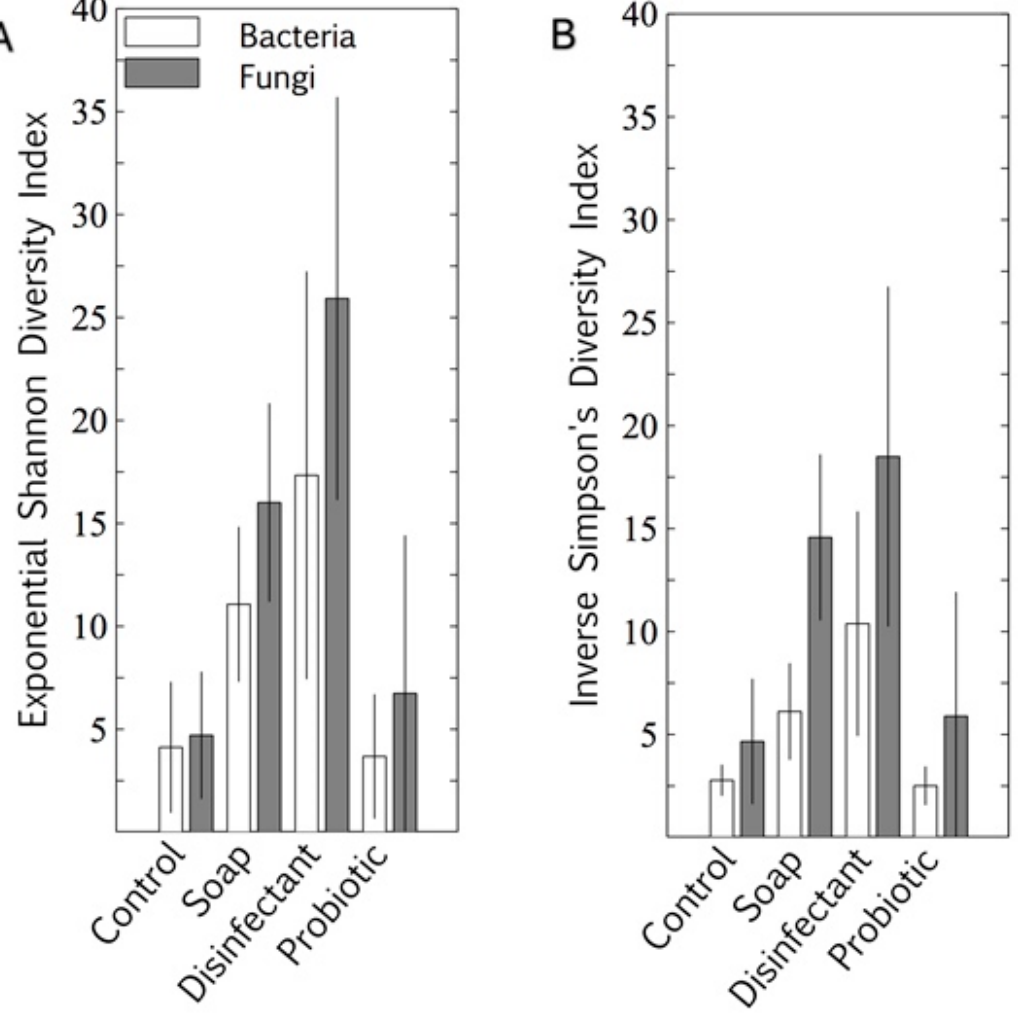
Figure 2. Bacterial and fungal alpha diversity indices of four cleaning regimes on indoor linoleum blocks, quantified as exponential Shannon diversity index ( A ) and inverse Simpson diversity index ( B ). Results are expressed as mean ± SD of quadruplicate swab samples.